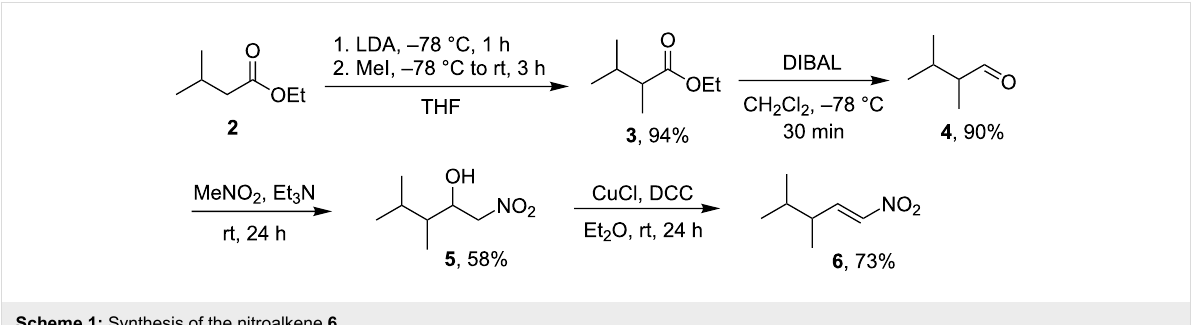
Scheme 1: Synthesis of the nitroalkene 6 .